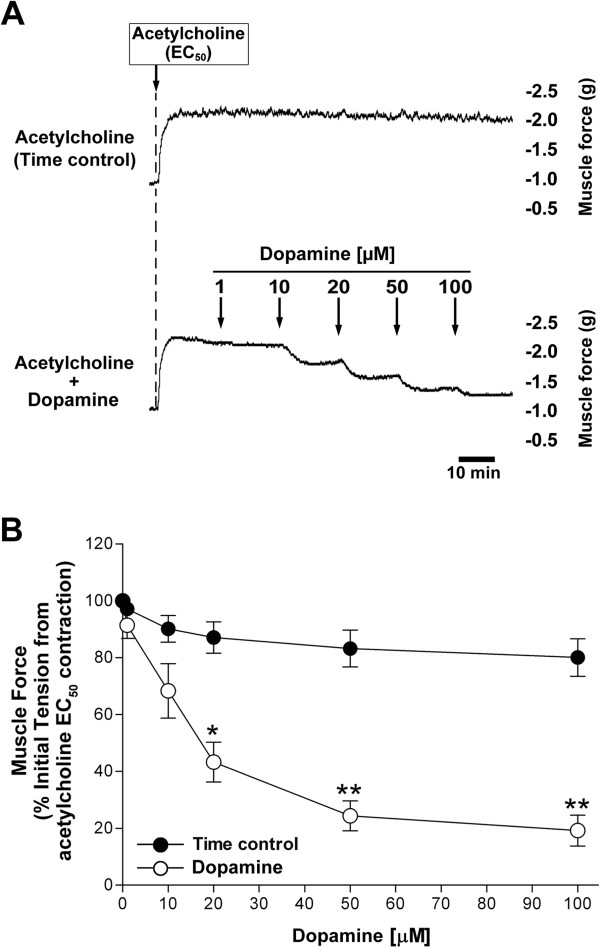
Dopamine induced airway smooth muscle relaxation after an acetylcholine EC50 contraction in intact guinea pig trachea. Dopamine, in a concentration-dependent manner, relaxes acetylcholine (Ach)-induced contractions in guinea pig tracheal rings. (A) Representative tension tracing in guinea pig tracheal ring illustrating relaxation of Ach (EC50) contraction by dopamine (1 - 100 μM). (B) The effect of cumulative concentration of dopamine (1 - 100 μM) on Ach (EC50)-induced guinea pig tracheal ring contraction. Open circles: dopamine alone. Filled circles: time control. Means ± SEM. *P < 0.05 and **P < 0.01 compared with time control. N = 5.